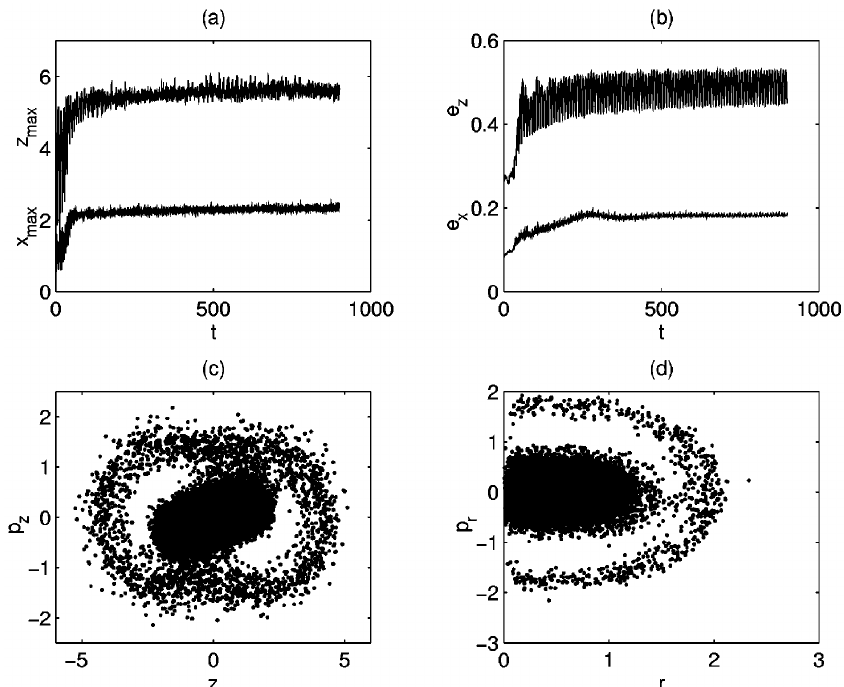
FIG. 13. 6D stationary distribution m (cid:120) (cid:173) m (cid:121) (cid:173) m (cid:122) (cid:173) (cid:49)(cid:46)(cid:53) ( (cid:99) (cid:121) (cid:97) (cid:173) (cid:51)(cid:44) h (cid:120) (cid:173) (cid:48)(cid:46)(cid:53)(cid:51)(cid:44) h (cid:122) (cid:173) (cid:48)(cid:46)(cid:51)(cid:57) ): (a) maximum (cid:120) and (cid:122) , (b) emittance growth, (c) (cid:122) (cid:45) (cid:112) (cid:122) diagram at (cid:116) (cid:173) (cid:57)(cid:48)(cid:48) (with 32 768 particles plotted), and (d) (cid:114) (cid:45) (cid:112) (cid:114) diagram at (cid:116) (cid:173) (cid:57)(cid:48)(cid:48) for particles with the angular momentum j (cid:76) (cid:122) j , (cid:48)(cid:46)(cid:49) (with 25 00 particles